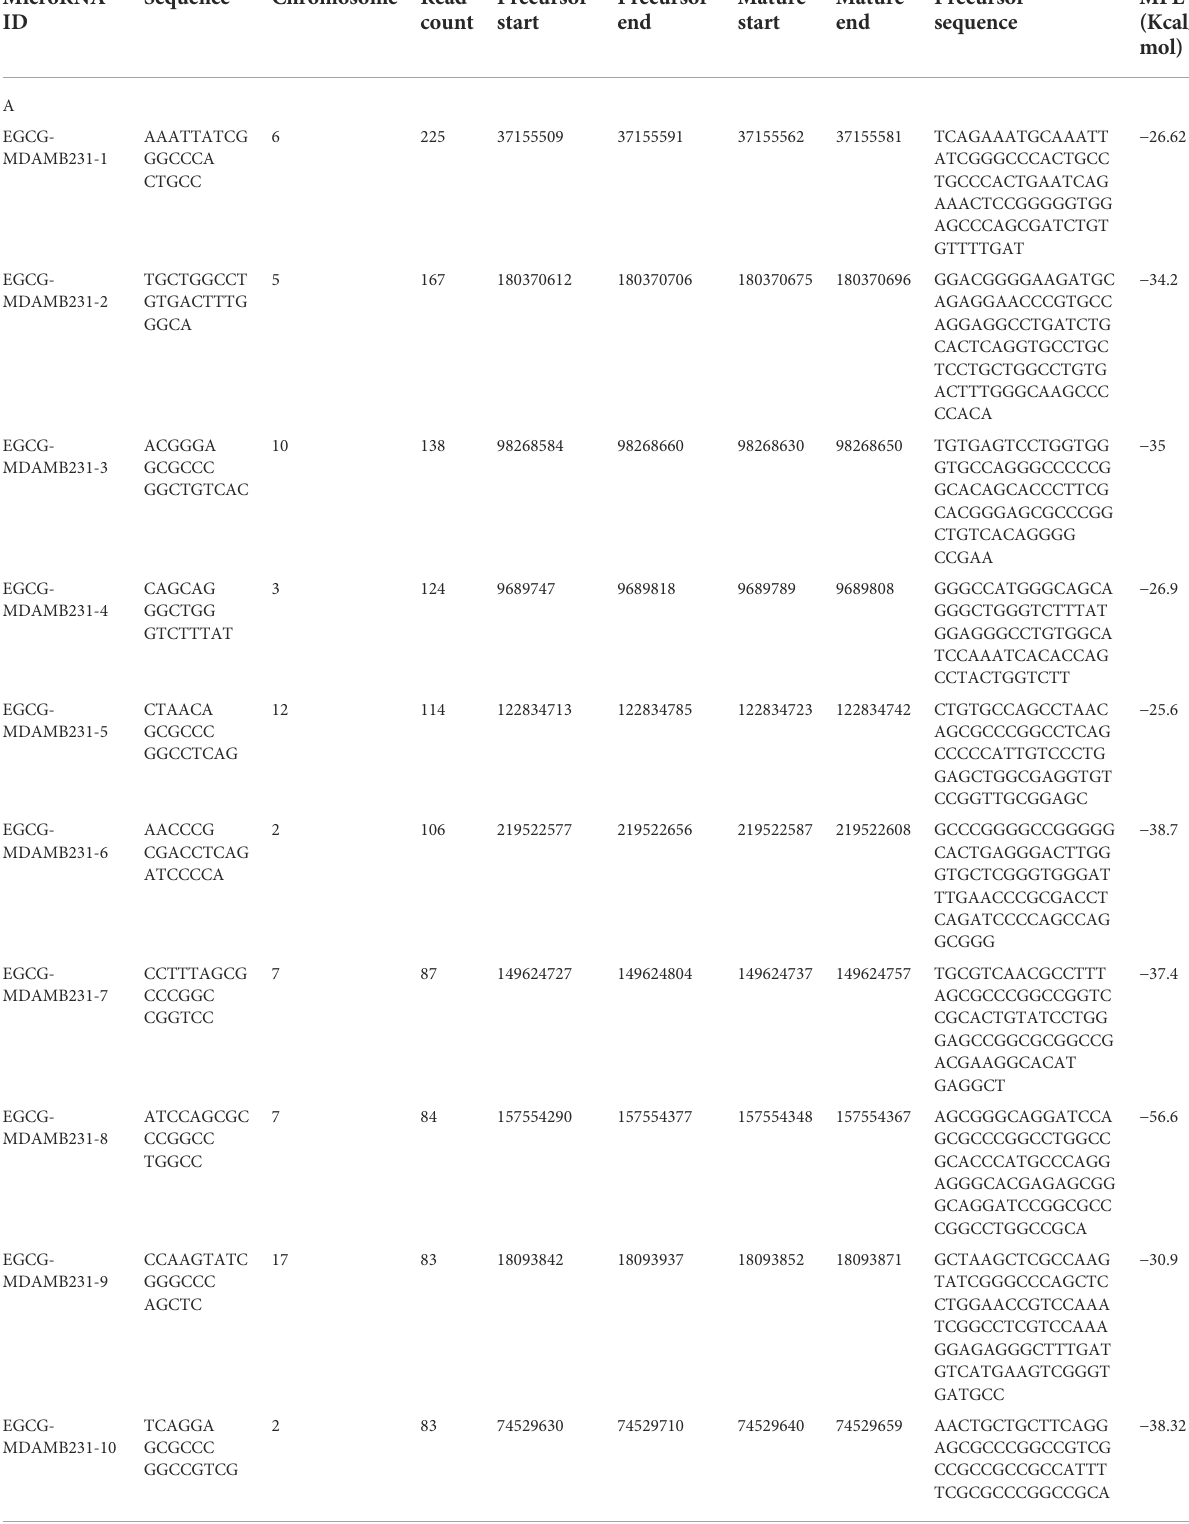
TABLE1A:Top10putativemicroRNA sequencesexpressedinthe untreatedcontrol.B:Top10putativemicroRNA sequencesexpressedinthe 83 μ M EGCG